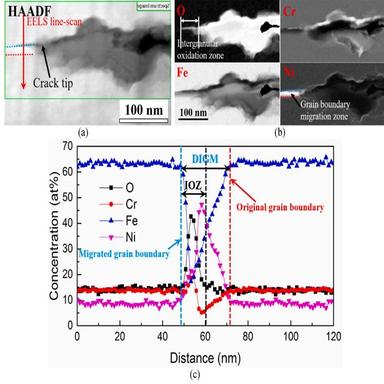
(a) HAADF image showing the morphology around a representative crack tip prepared from Fe-16Cr-11Ni alloy tested at 360 ◦C; (b) EELS elemental O K edge and Cr/Fe/Ni L edge maps; (c) EELS quantitative composition line profiles across the IOZ and DIGM zone.